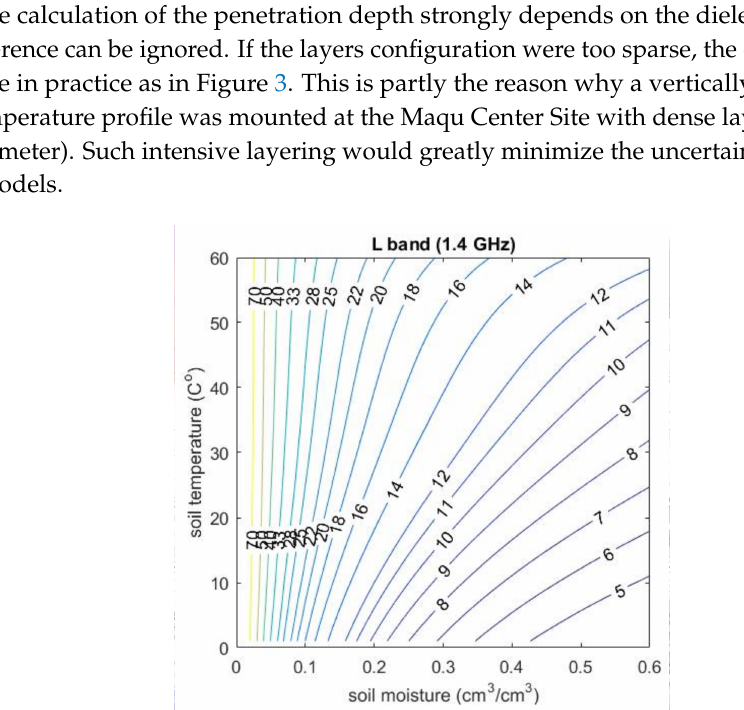
Figure 3. Penetration depth at L band (1.4 GHz). The ranges of penetration depth (in centimeters) were shown as contour lines, depending on the soil moisture and soil temperature. Mironov’s dielectric constant model was used here for calculating the real and complex parts of dielectric